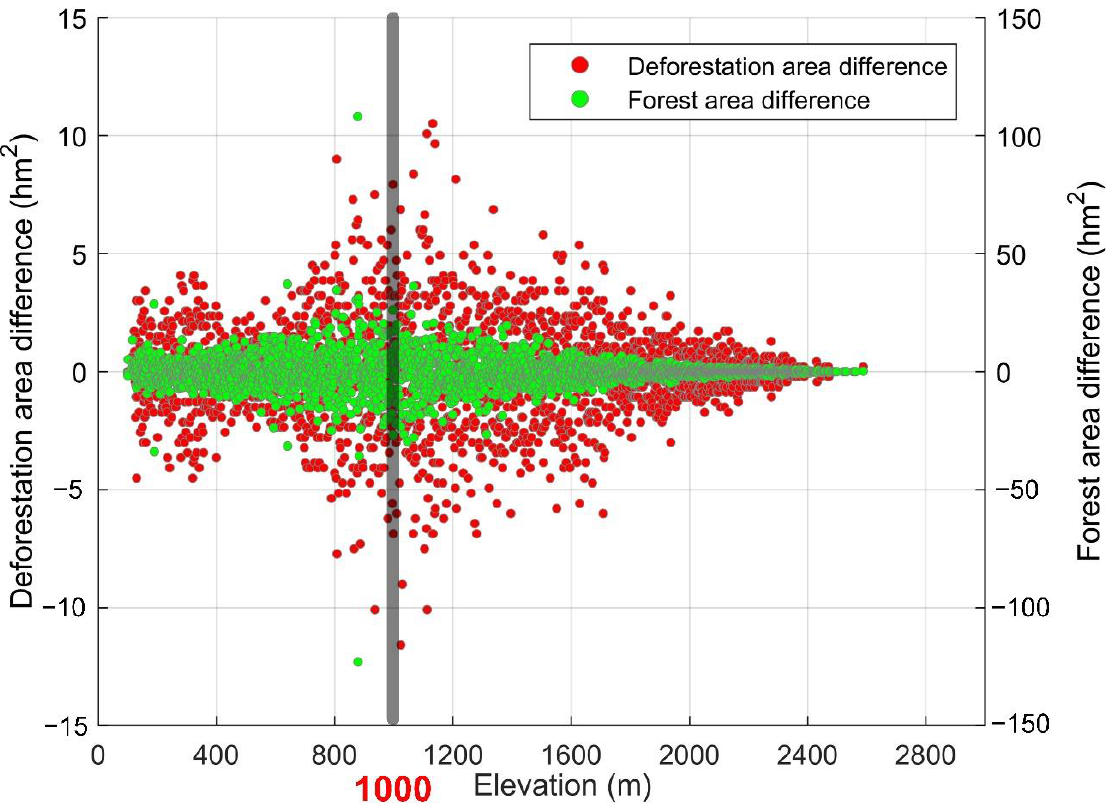
Figure 6. Comparison of the variations in the deforestation and forest areas by elevation from 2003 to 2015 in upland Myanmar.